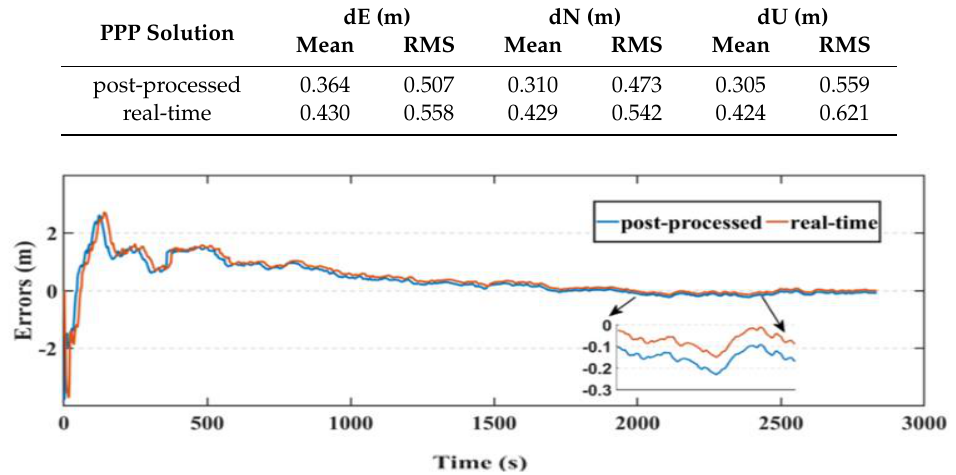
Table 4. Mean and RMS of East, North, and Up errors for the first data set.